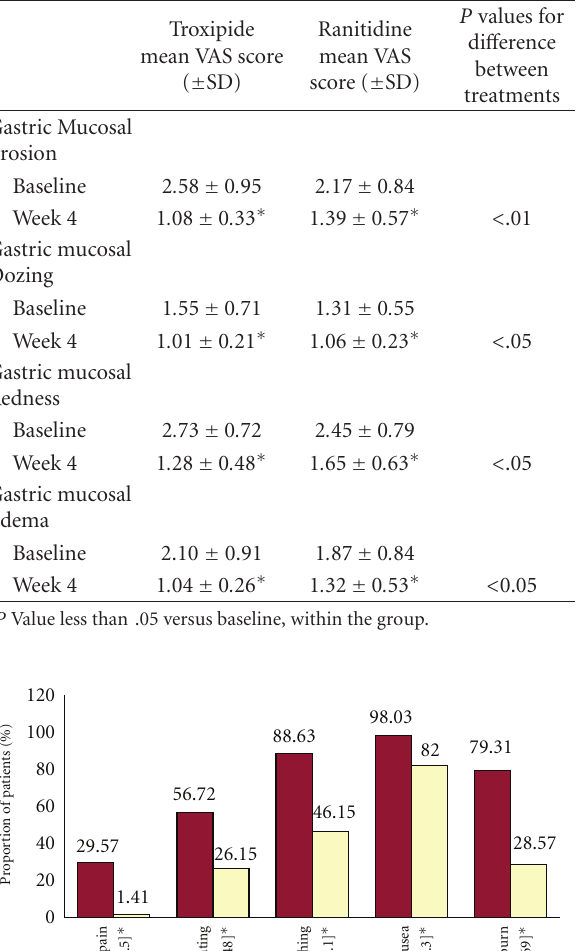
Table 3: Mean Visual Analog Scale (VAS) scores for Gastritis symptoms in patients at baseline, week 2 and week